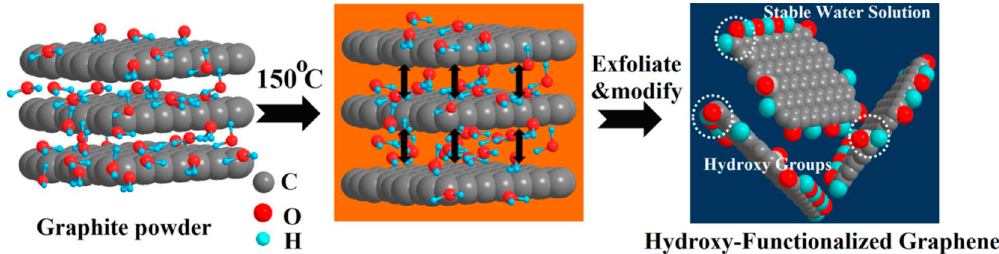
Figure 24. Schematic illustration of the exfoliation process. Reproduced from [117]. Copyright Nature Publishing Group, 2018.